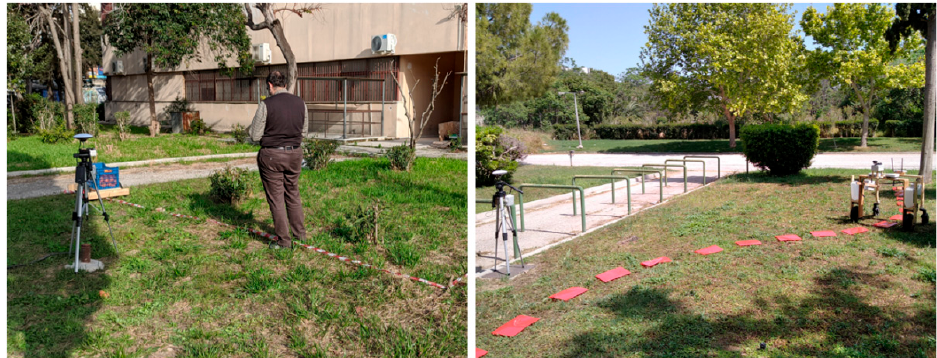
Figure 11. Experiments of evaluating the positioning accuracy of the fruit transporting and